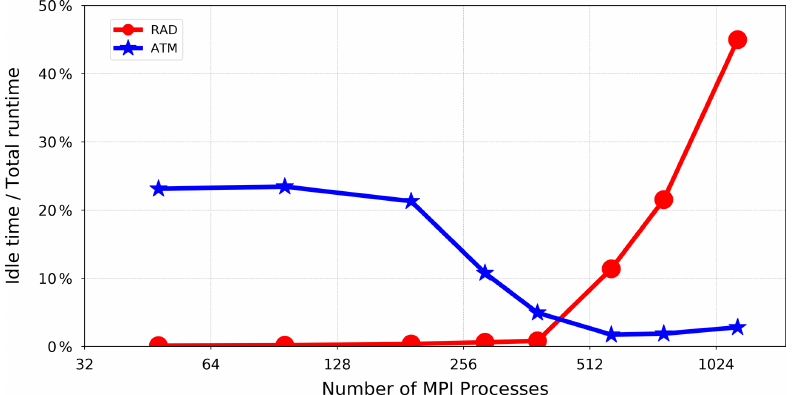
Figure 10. The red curve (RAD) shows the increasing idle time of the MPI processes responsible for resolving radiative transfer. It suggests that RAD is a dominant computation in all the configurations before 576 MPI processes and does not wait for ATM. The blue curve (ATM), on the other hand, shows that resolving other atmospheric physics and dynamics is not a dominant computation for all the configurations before 576 MPI processes, and ATM therefore experiences a long idle time. However, ATM becomes dominant towards the end, inflicting a long idle time on RAD. Yet the idle time of ATM is not lifted completely. This can be attributed mainly to the unavoidable waiting time of ATM in the first (radiation) time step (as reflected in Fig. 4) and some infrequent (slightly) longer radiation time steps.